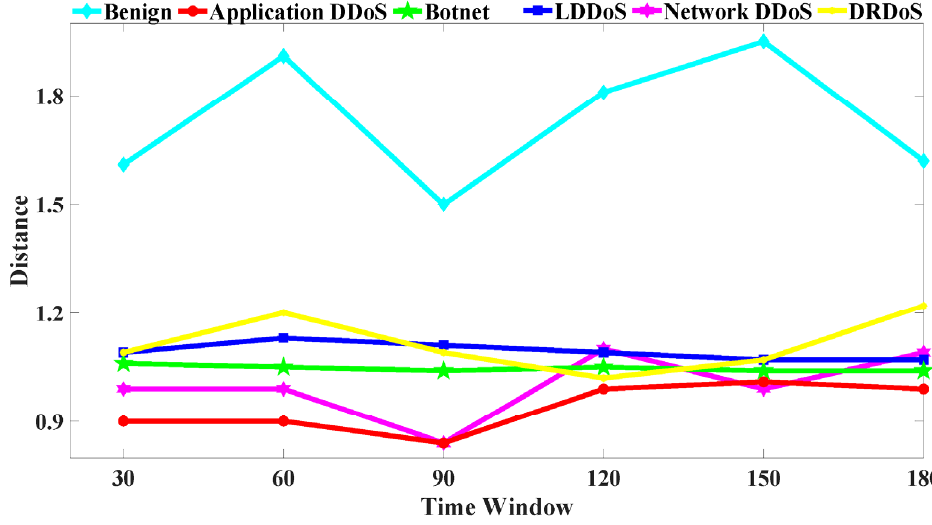
Figure 4. Distance of MFPK method between benign vs. attack traffic.